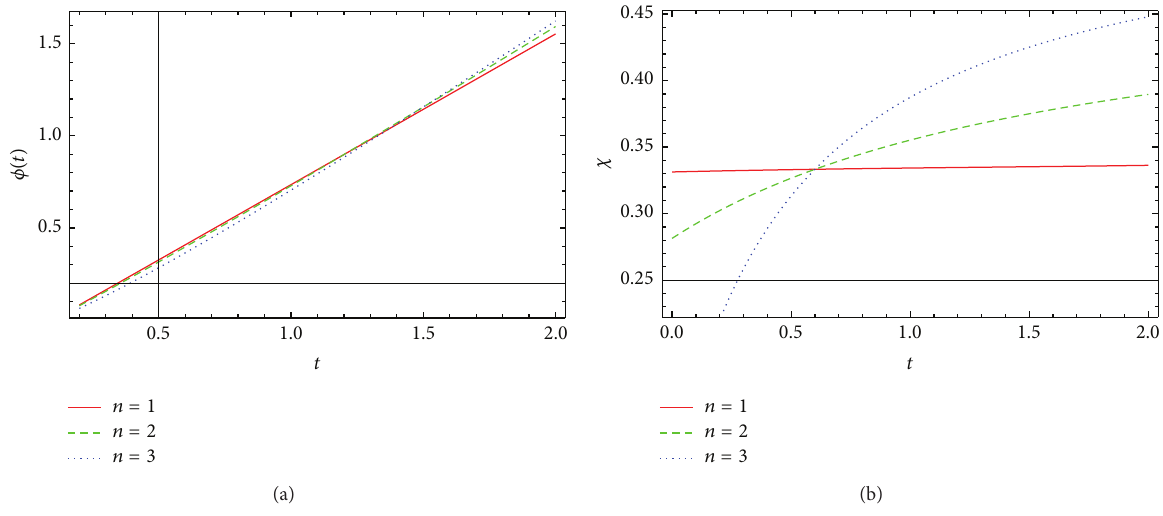
Figure 5: Plots of 𝑓(𝑅,∇𝑅) k- essence scalar field: (a) 𝜙 versus cosmic time 𝑡 and (b) kinetic energy term 𝜒 versus 𝑡 for 𝑛 = 1 (red), 𝑛 = 2 (green), and 𝑛 = 3 (blue).